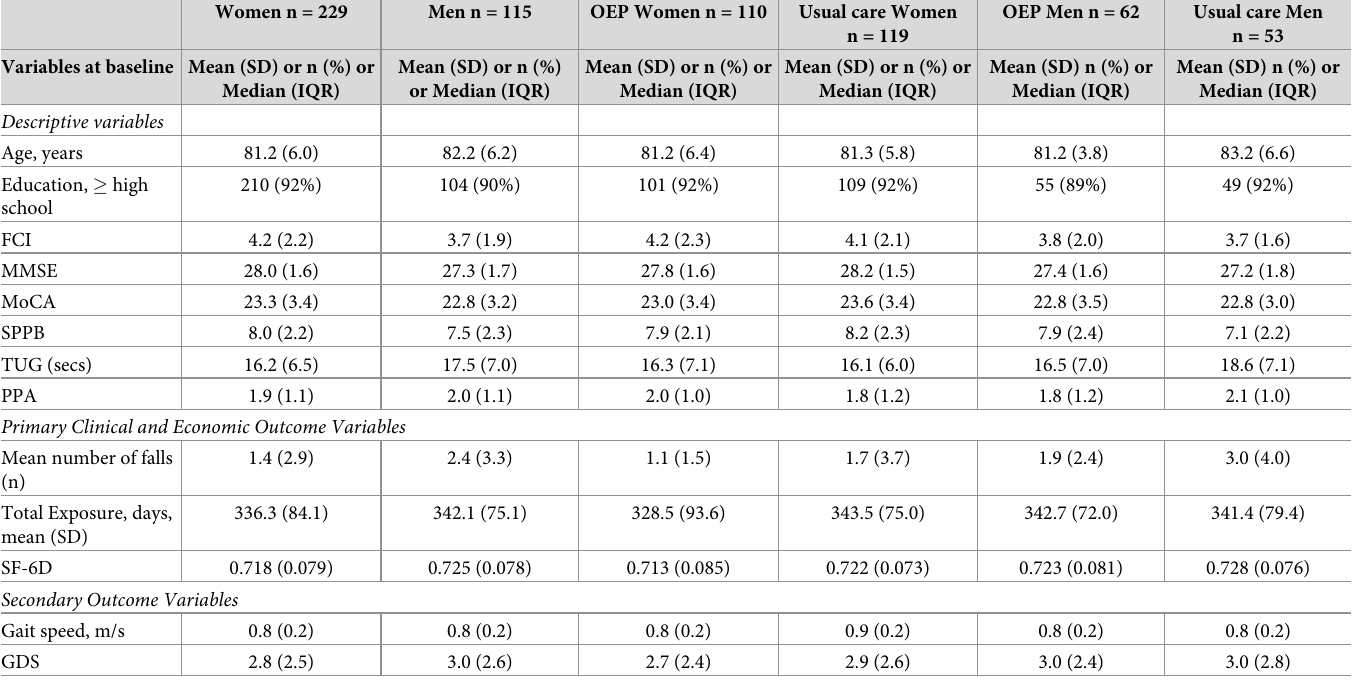
Table 1. Characteristics of randomized clinical trial participants stratified by gender. Women n = 229 Men n = 115 OEP Women n = 110 Usual care Women OEP Men n = 62 Usual care Men n = 119 n = 53 Variables at baseline Mean (SD) or n (%) or Mean (SD) or n (%) Mean (SD) or n (%) or Mean (SD) n (%) or Median (IQR) or Median (IQR) Median (IQR) Median